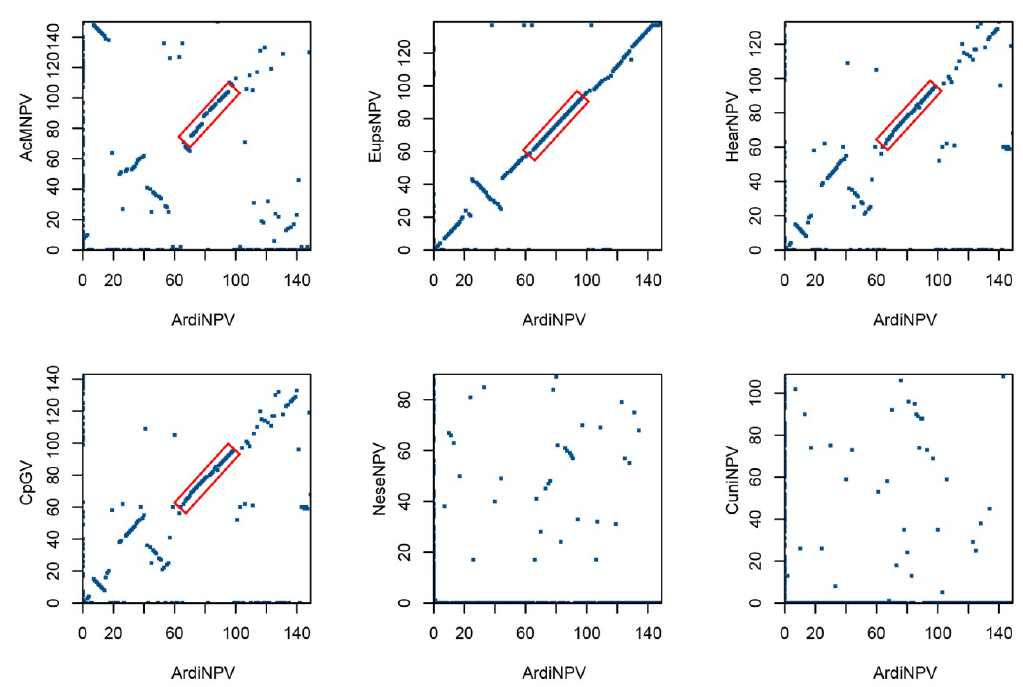
Figure 3. Gene parity plot analysis. Gene parity plots of ArdiNPV compared to representative baculoviruses, including AcMNPV (Group I, α ), EupsNPV (Group II, α ), HearNPV (alphabaculovirus minor group, α ), CpGV ( β ), NeseNPV ( γ ), and CuniNPV ( δ ). The box indicates the lepidopteran baculovirus collinear region.